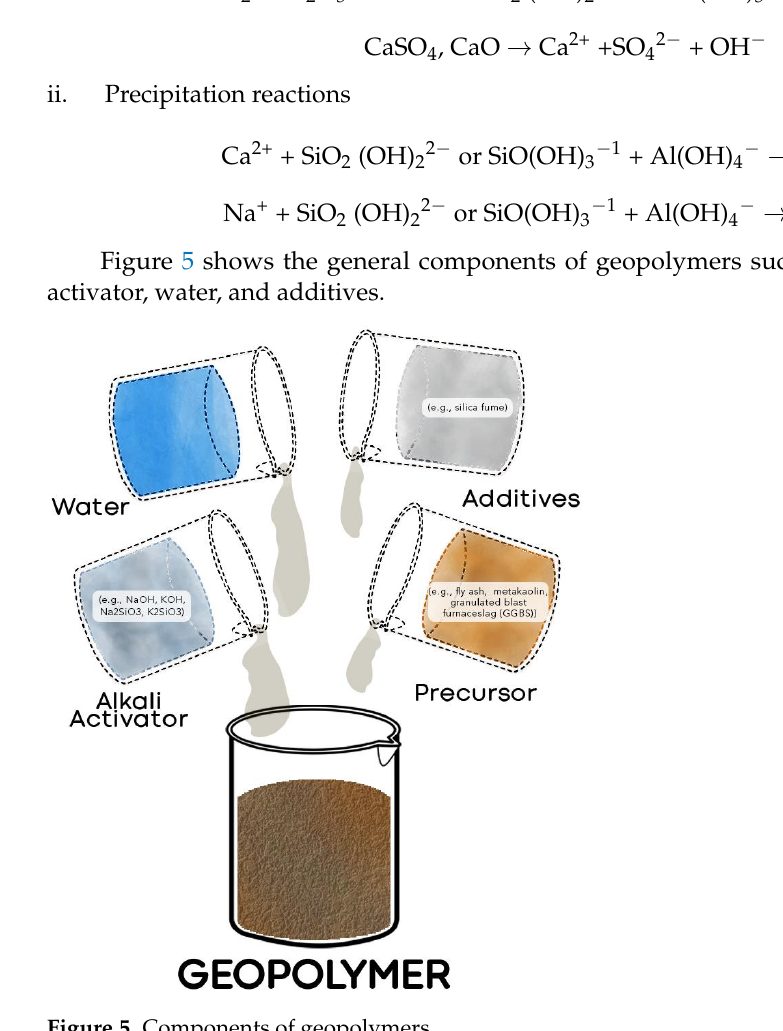
Figure 5. Components of